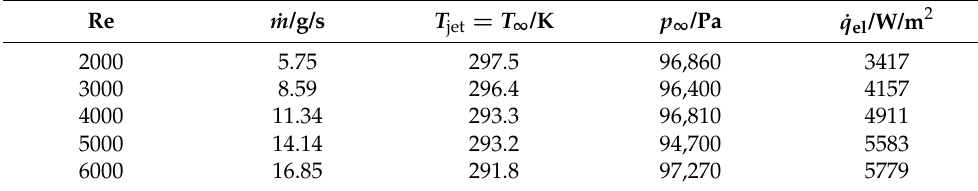
Table 3. Overview of experimental conditions.